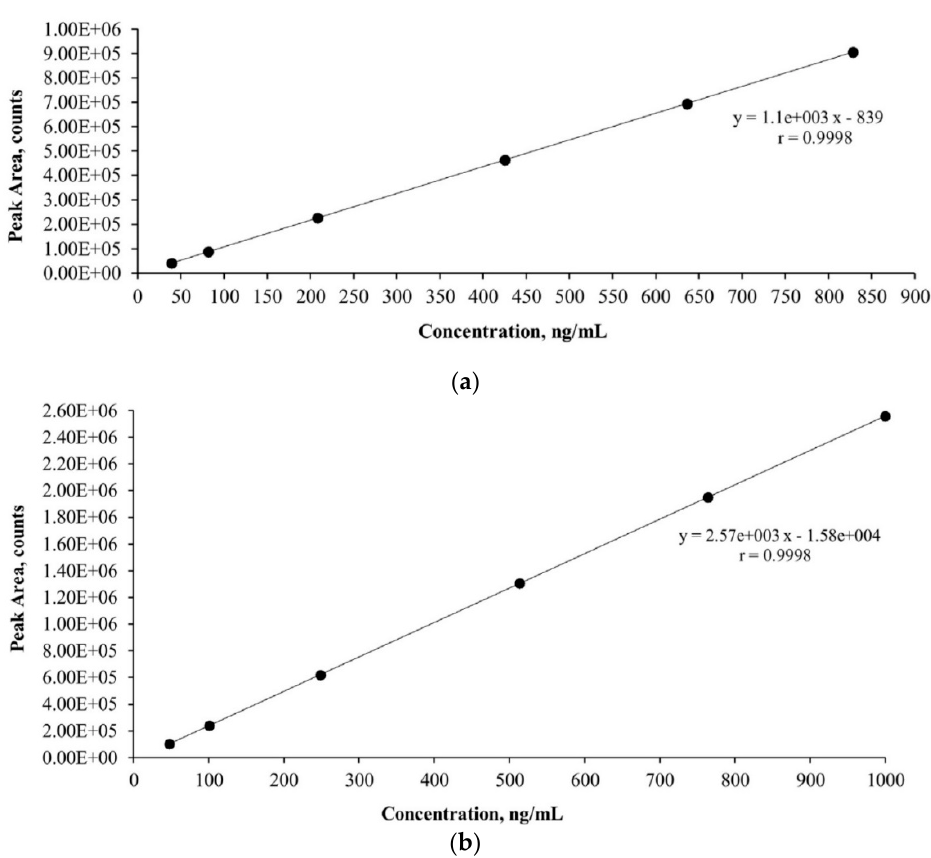
Figure 1. ( a ) Linear response of AMX. ( b ) Linear response of CIP.